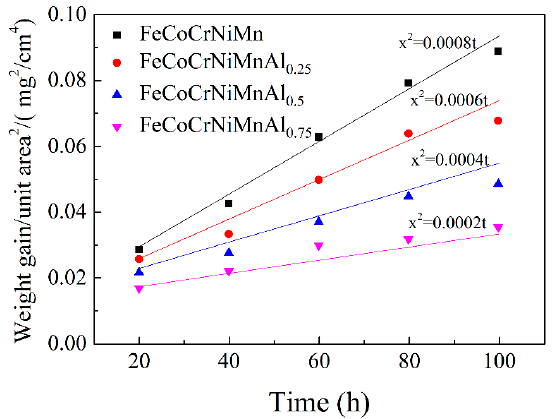
Figure 7. Oxidation kinetics regression curves of the FeCoCrNiMnAl x cladding layers.